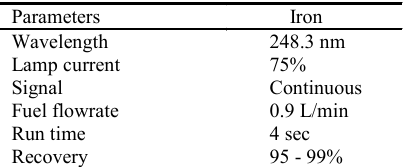
Table 1: FAAS Operation conditions